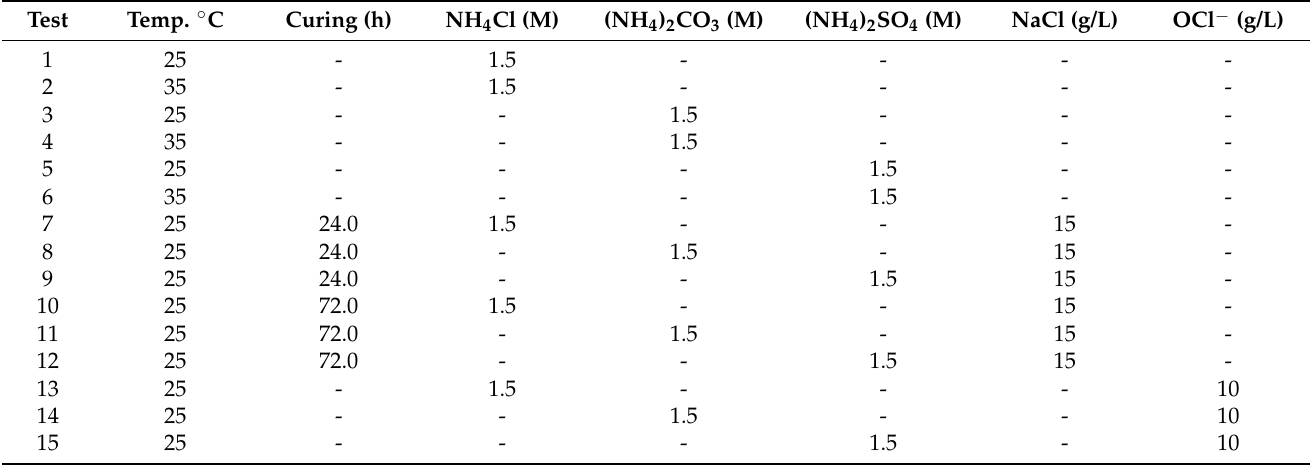
Table 3. Shake flask leaching conditions of enargite concentrate.